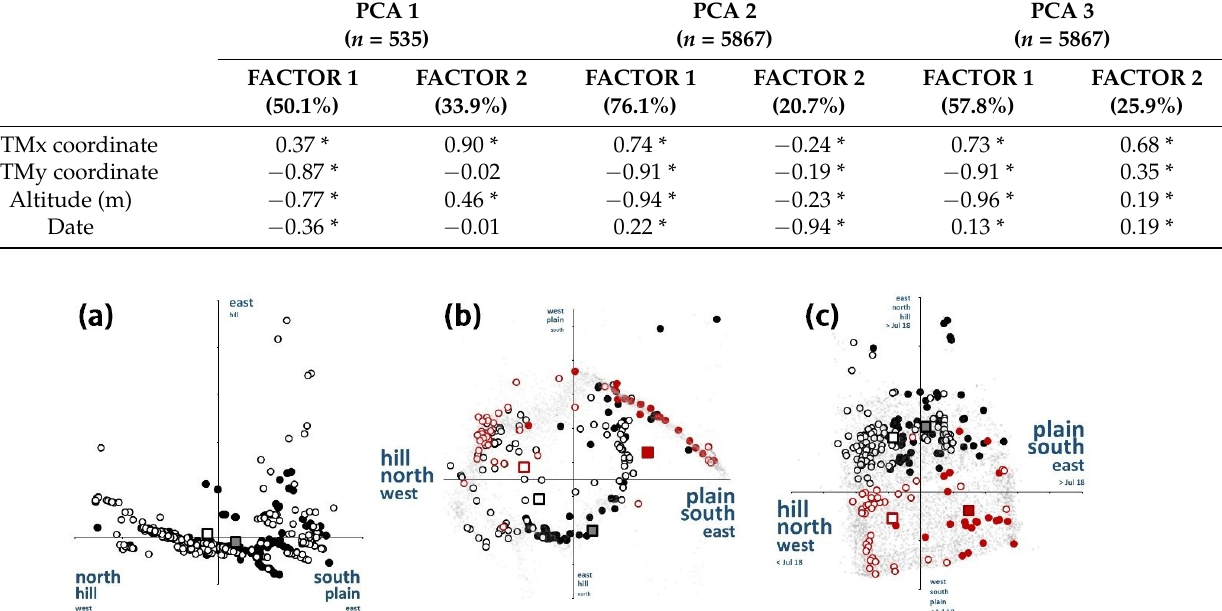
Figure 6. Distribution in the space defined by the two main factors of a principal component analysis (PCA) applied to a matrix where the rows are sites and the columns are the X, Y, and Z (altitude, m) coordinates of each record, plus date, in the case of ( c ). ( a ) PCA 1: every dot represents a location for the Iberian hare ( Lepus granatensis ) (black dots) and/or rabbit ( Oryctolagus cuniculus ) (white dots) registered between 1995 and 2019 ( n = 535), ( b ) PCA 2. ( c ) PCA 3. In addition to the axis, the inter- pretation of each factor is indicated. The size of the words tends to be roughly proportional to the importance of each feature (see Table 3 for details). The squares represent the centroids of each spe- cies or species and date distribution. In ( b , c ), solid dots are hare records (black indicating those made prior to July 2018, when the myxomatosis outbreak started in the study area, and red for those after July 2018). Empty dots represent rabbit records (black prior to July 2018 and red after July 2018). Grey dots: points without lagomorph records. n = 5867 total points (88 hares and 132 rabbits). The spatial distribution patterns of lagomorphs changed statistically after the myxo- matosis outbreak (Figure 6 b,c). First, before the start of the epidemic, the space used by hares and rabbits, although statistically different, overlapped extensively (Figure 6a). Af- ter July 18, the distribution of both species became much more allopatric. Hares occupied the positive end of the gradient defined by Factor 1 in PCA 2 and PCA 3, while rabbits did the opposite (Figure 6b,c). Rabbits tended to maintain their average habitat (albeit disap- pearing from many localities), whereas hares were markedly displaced to the south-east